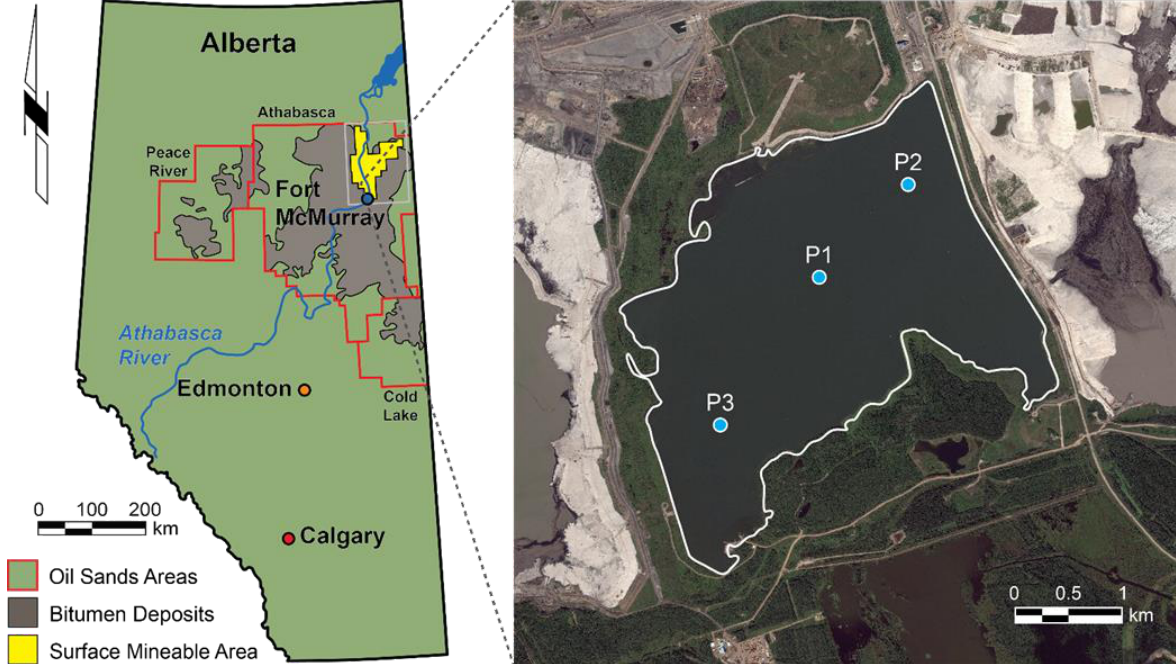
Figure 2. Sampling site showing the distribution of oil sands in northern Alberta and the location of Base Mine Lake (BML: black dot). The second panel shows a close up of BML showing the locations of the three primary sampling platforms referred to in this study.